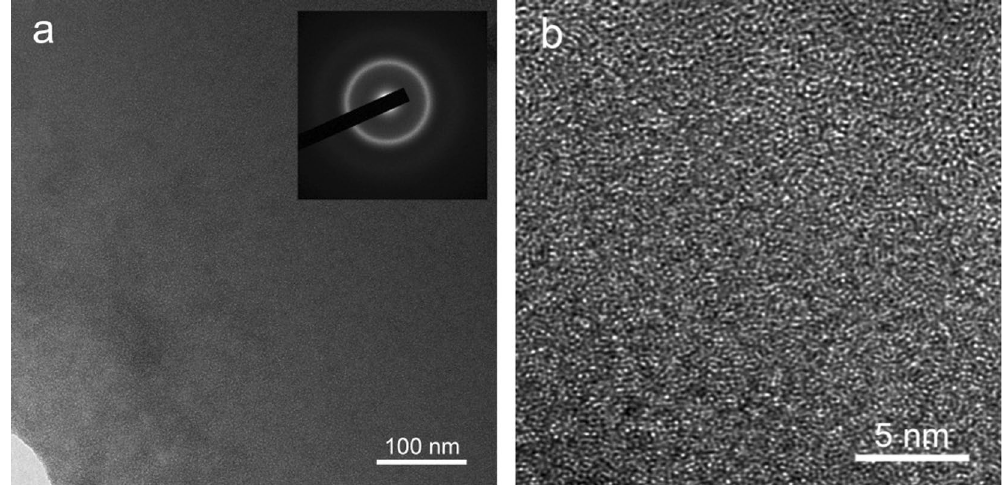
Figure 2. The amorphous microstructure of Zr 50 Cu 44 Al 6 alloy. ( a ) TEM with a SAED pattern (inset) and ( b ) HRTEM.